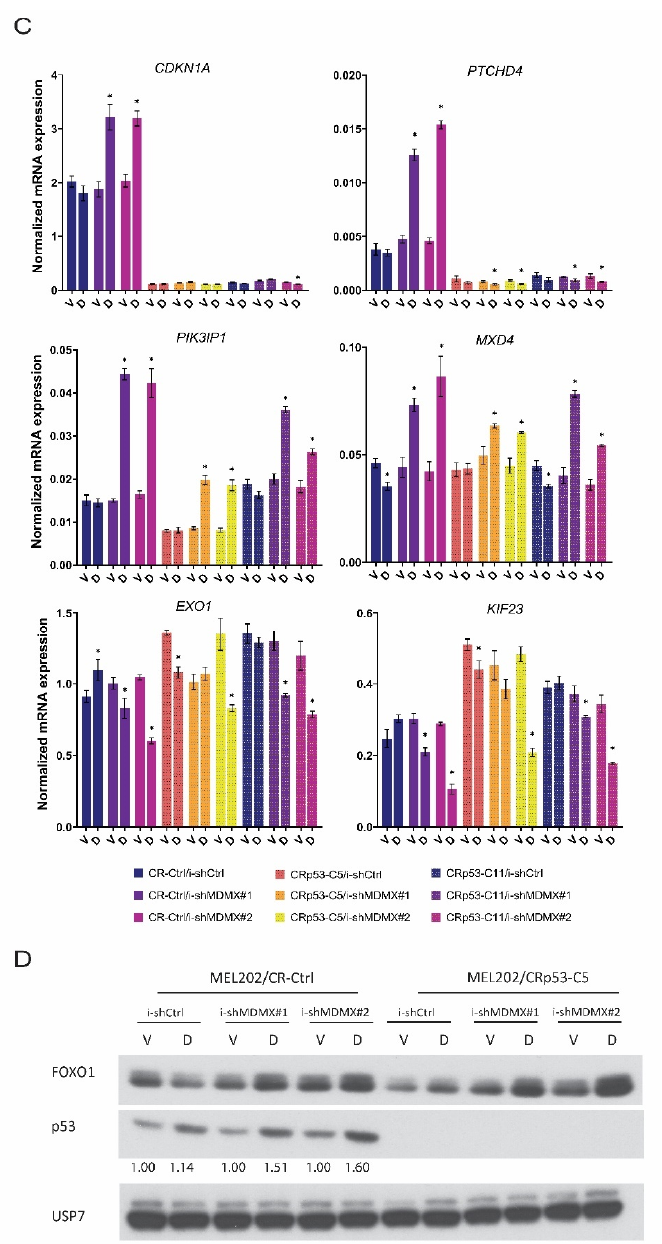
Figure 2. Verification of MDMX target genes. ( A ) Relative, normalized mRNA expression of CENPF , KIF23 , PIK3IP1 and PTCHD4 genes after 48 h of doxycycline (D 10 ng/mL) or Vehicle (V) treatment of indicated cell lines. CENPF and KIF23 are downregulated and PIK3IP1 and PTCHD4 are upregulated upon MDMX knockdown. Significant alterations ( p < 0.05) in expression levels are indicated with *. ( B ) Analysis of protein expression after 48 h doxycycline treatment shows a consistent repression of MAD2L1 level and an increase in p53, FOXO1, p21 and PUMA levels upon MDMX depletion. ( C , D ) MEL202/CR-Ctrl and MEL202/CR-p53 cells were depleted for MDMX (48 h doxycycline (D), 10 ng/mL) or control-treated (V) after which RNA and protein lysates were harvested and analysed by qRT-PCR ( C ) and Western blotting ( D ). Significant alterations ( p < 0.05) in expression levels are indicated with *. Original blots see Supplementary File